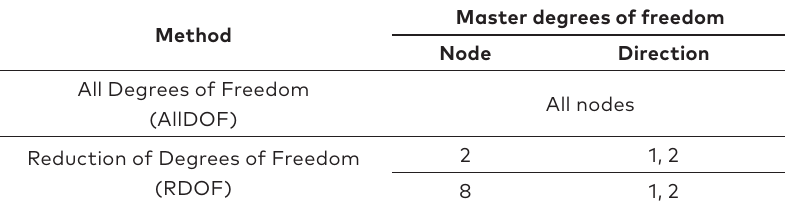
Table 2. Master degrees of freedom for a 15-element